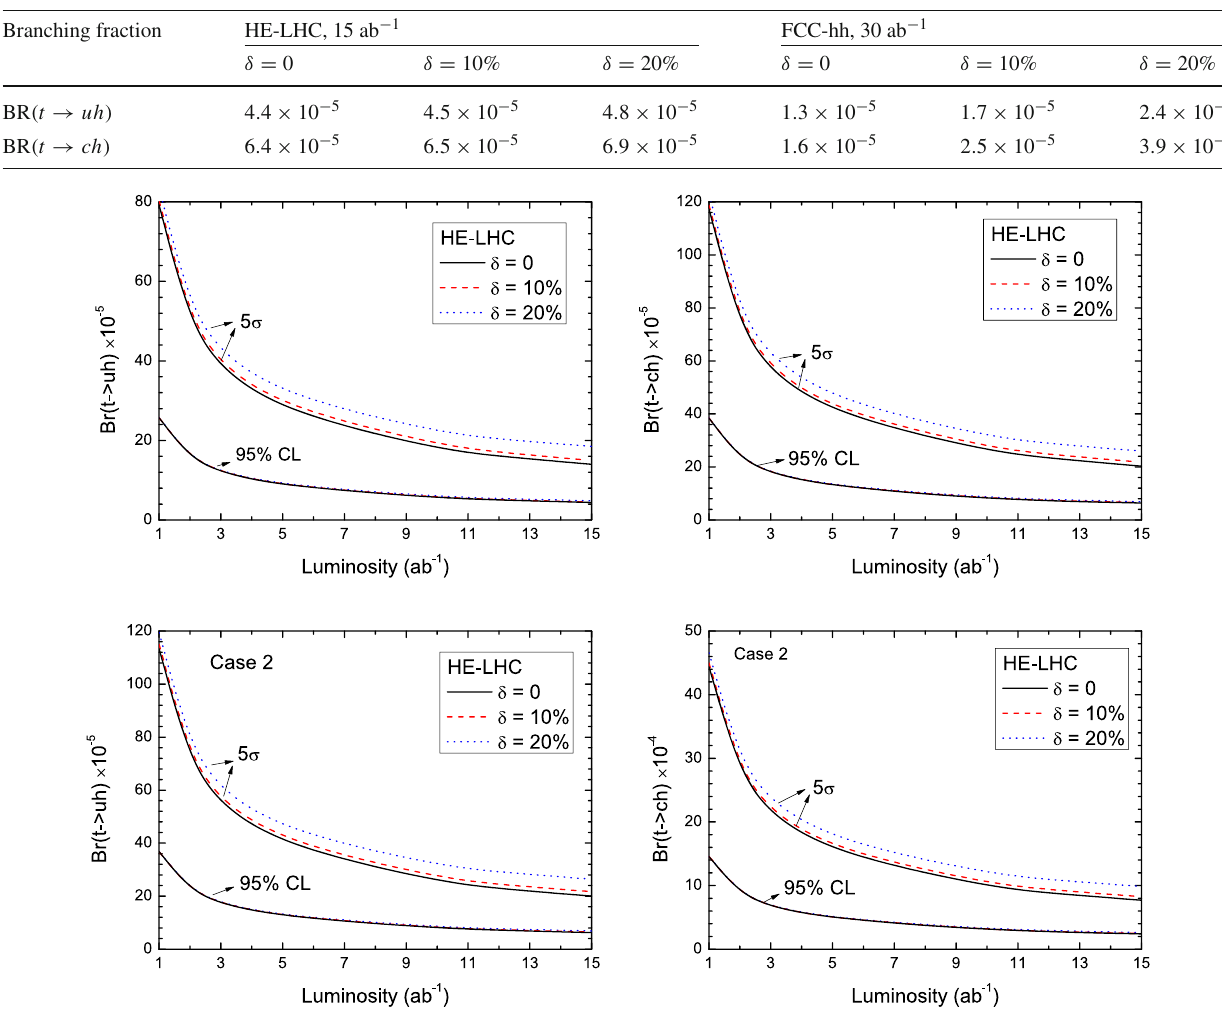
Fig. 4 The 95% and 5 σ contour plots for the signal in L int − Br ( t → uh ) (left) and L int − Br ( t → ch ) (right) planes at HE-LHC. For comparison, the results also plot the under two figures for the case of only considering the signal from the pp → th process